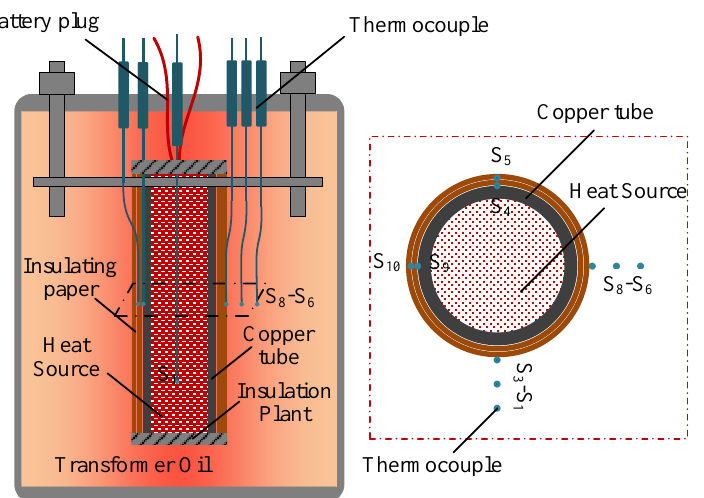
Figure 4. The steady-state round-tube experimental device. The stainless-steel tank and internal device are placed in a temperature and humidity programmable chamber. The internal temperature of the chamber is set at 295.15 K to reduce experimental errors caused by fluctuations in ambient temperature. A single-phase voltage regulator (model UTP3313TFL-II) provides a variable stable voltage to adjust the heating power. A digital voltmeter (model DS3A-DA2) and digital amperemeter (model MDH8-1A) record the heating power. Temperature loggers (model KCM-XJ16WRS) read the thermocouple temperature and upload the values to the host computer. The schematic diagram of the experimental platform is shown in Figure 5.